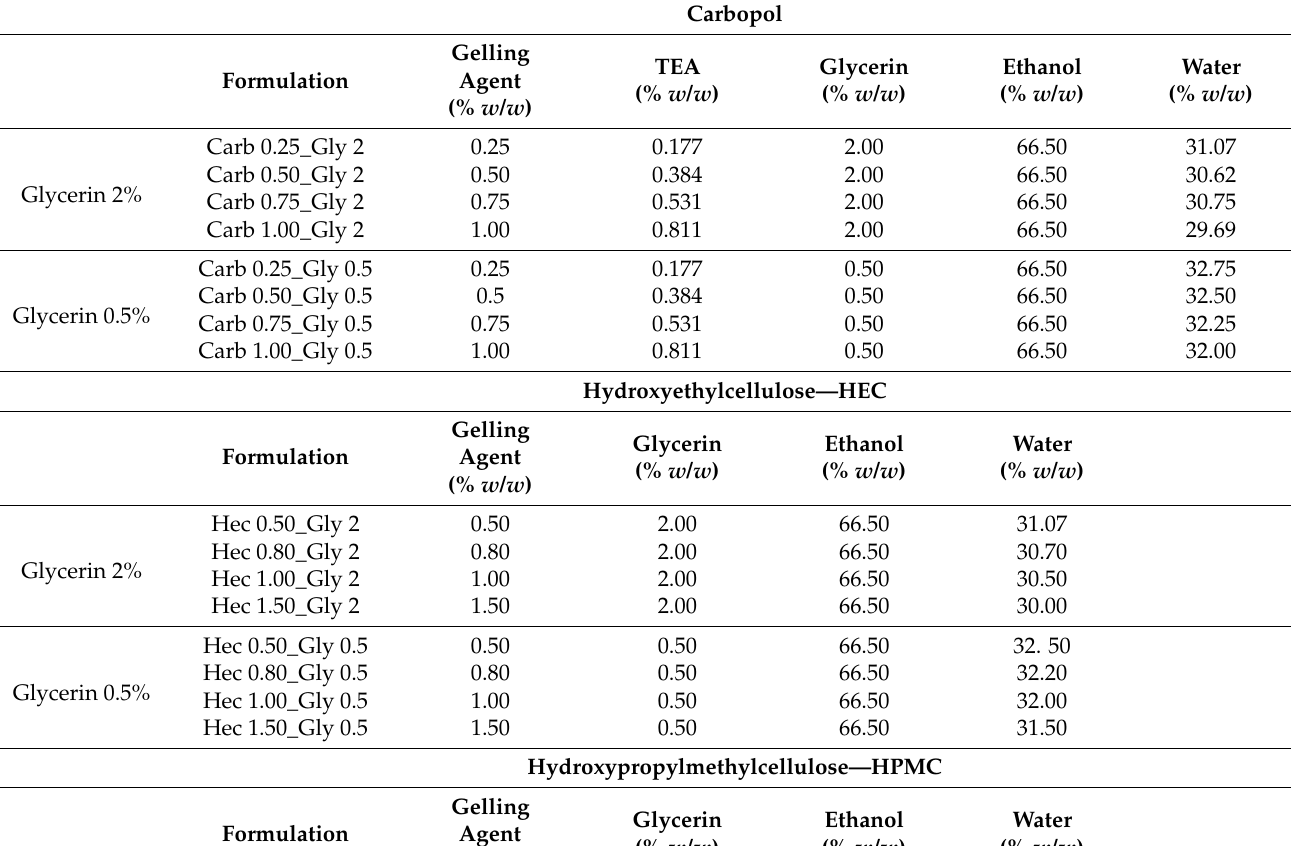
Table 1. Composition of the